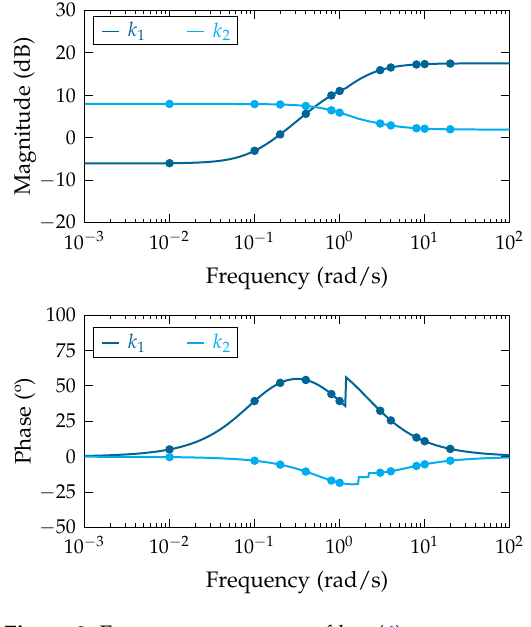
Figure 3. Frequency responses of k 1,2